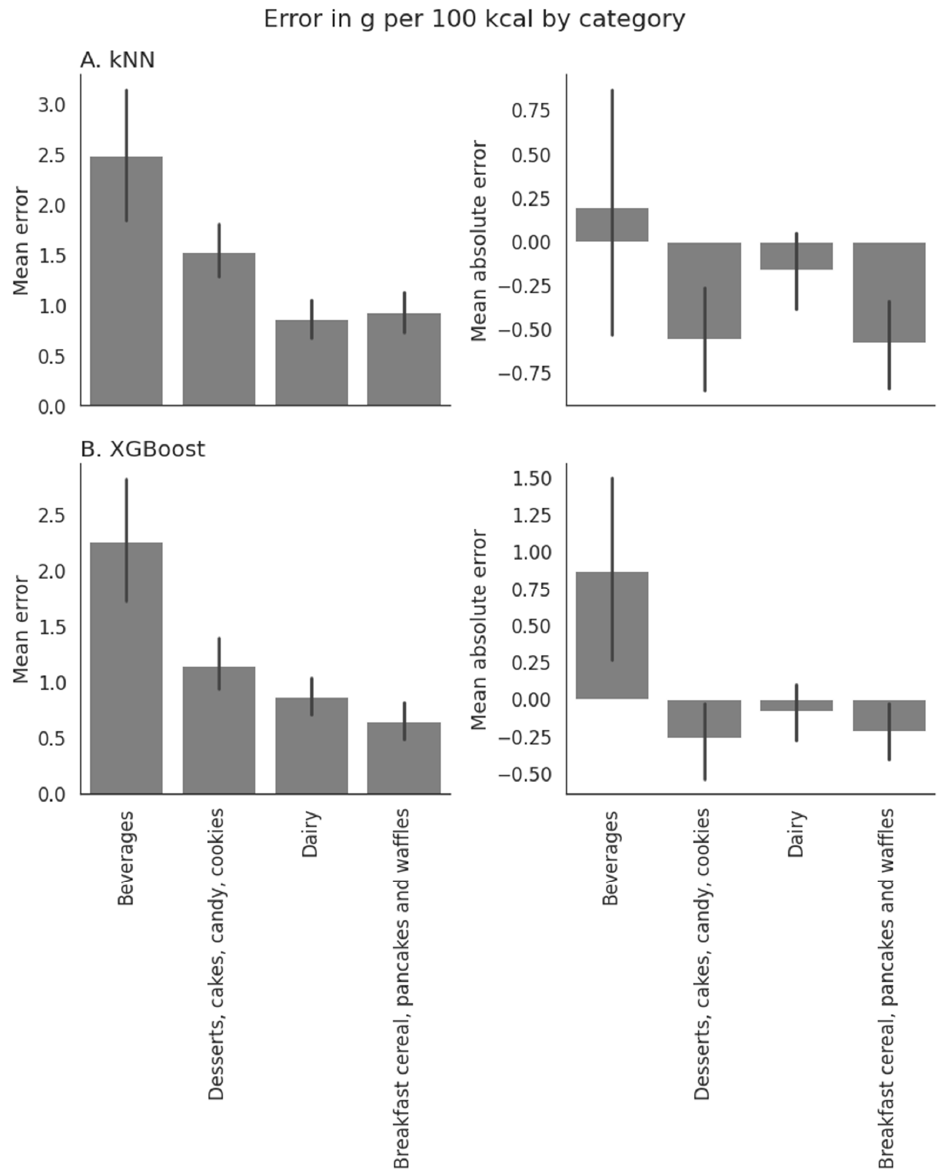
Figure 2. Mean absolute and mean error in the prediction of added sugar values in g per 100 kcal in